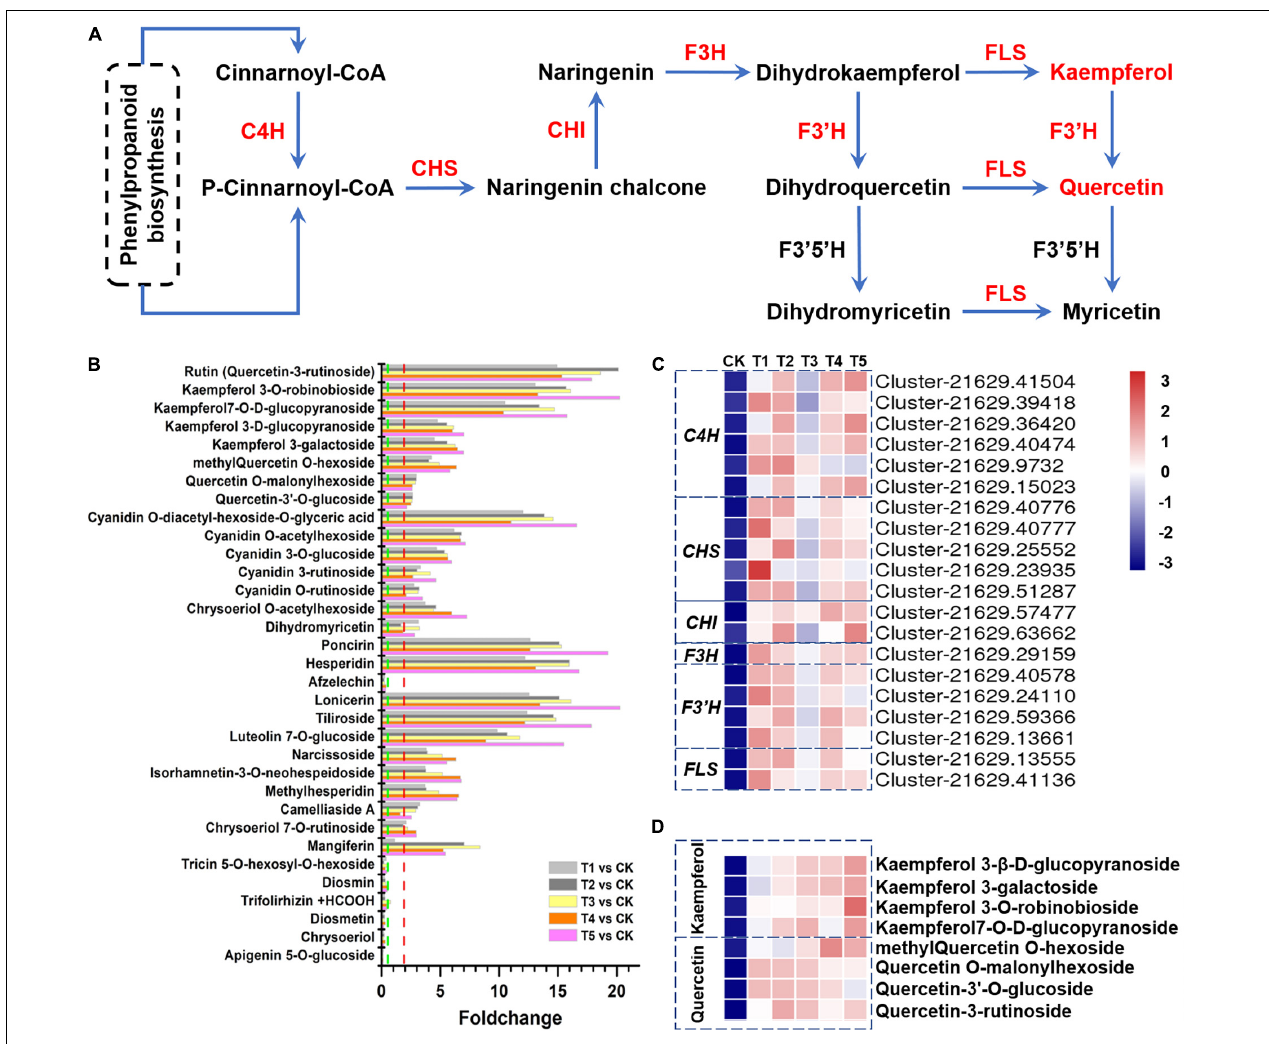
FIGURE 4 | Flavonoids in response to freezing stress. (A) Flavonol biosynthesis pathway and genes involved in this process. (B) The fold changes of flavonoid accumulation in plants subjected to each freezing stress compared with the control, including 26 upregulated and 7 downregulated flavonoid compounds. (C) The flavonol biosynthesis-associated genes were hierarchically clustered (Euclidean distance) based on their expression level. (D) The flavonols were hierarchically clustered (Euclidean distance) based on their abundance. C4H, cinnamate 4-hydroxylase; CHS, chalcone synthase; CHI, chalcone isomerase; F3H, flavanone 3-hydroxylase; F3’H, flavonoid 3’-hydroxylase; FLS, flavonol